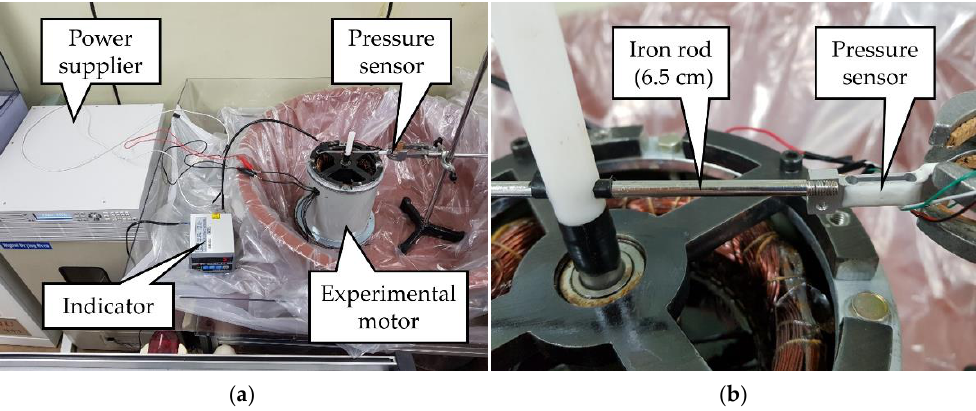
Figure 5. Equipment setup for measuring the output torque of the experimental motor: ( a ) overall view; ( b ) torque measurement iron rod and pressure sensor attached to it.